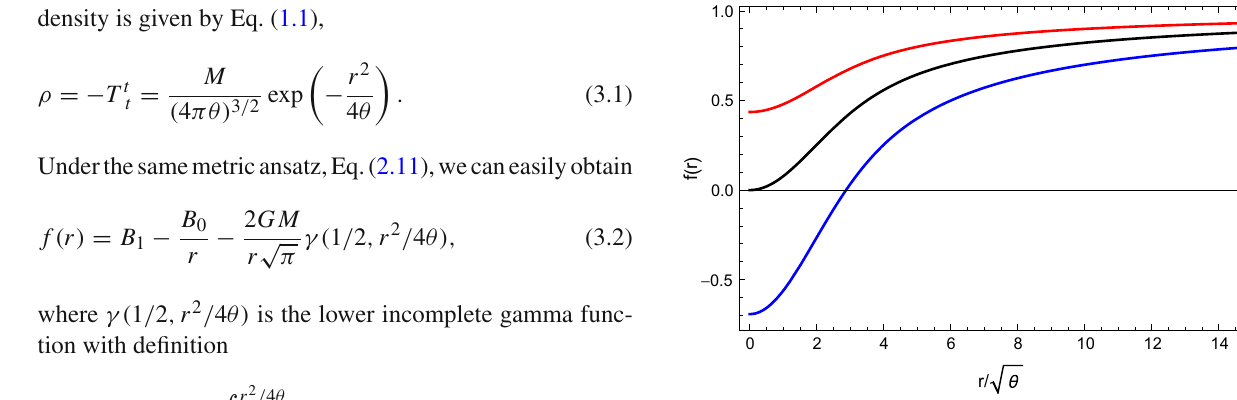
√ √ θ = 0 . 5 , π/ 2 , 1 . 5, respectively. We set